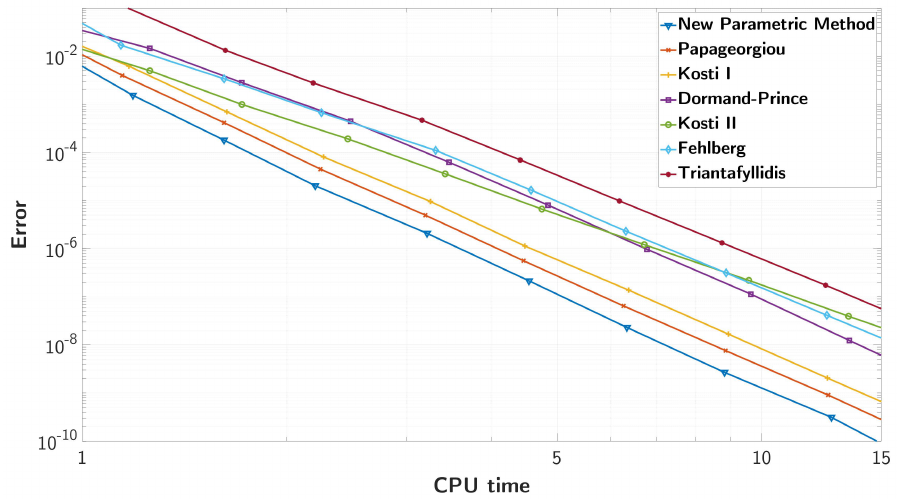
Figure 17. The maximum absolute error of the solution versus the CPU time, for all compared